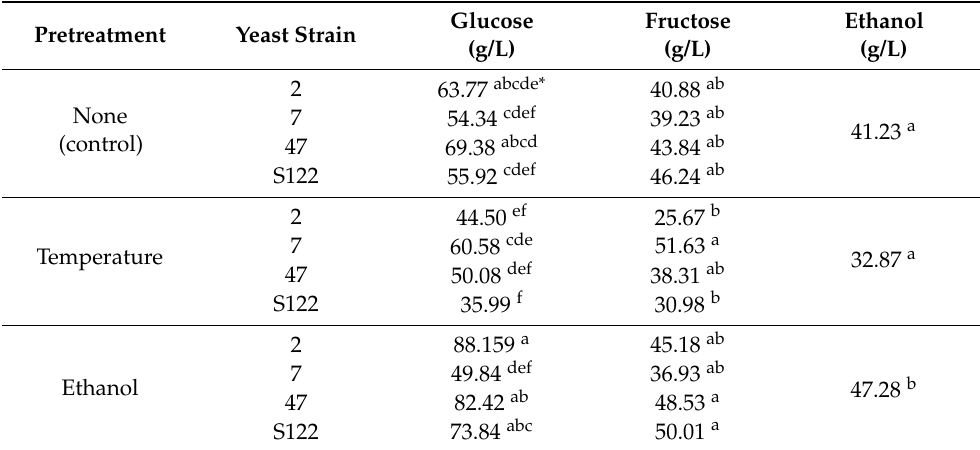
Table 3. Effect of interaction between type of pretreatment and type of strain on glucose, fructose levels and effect of treatment difference on ethanol